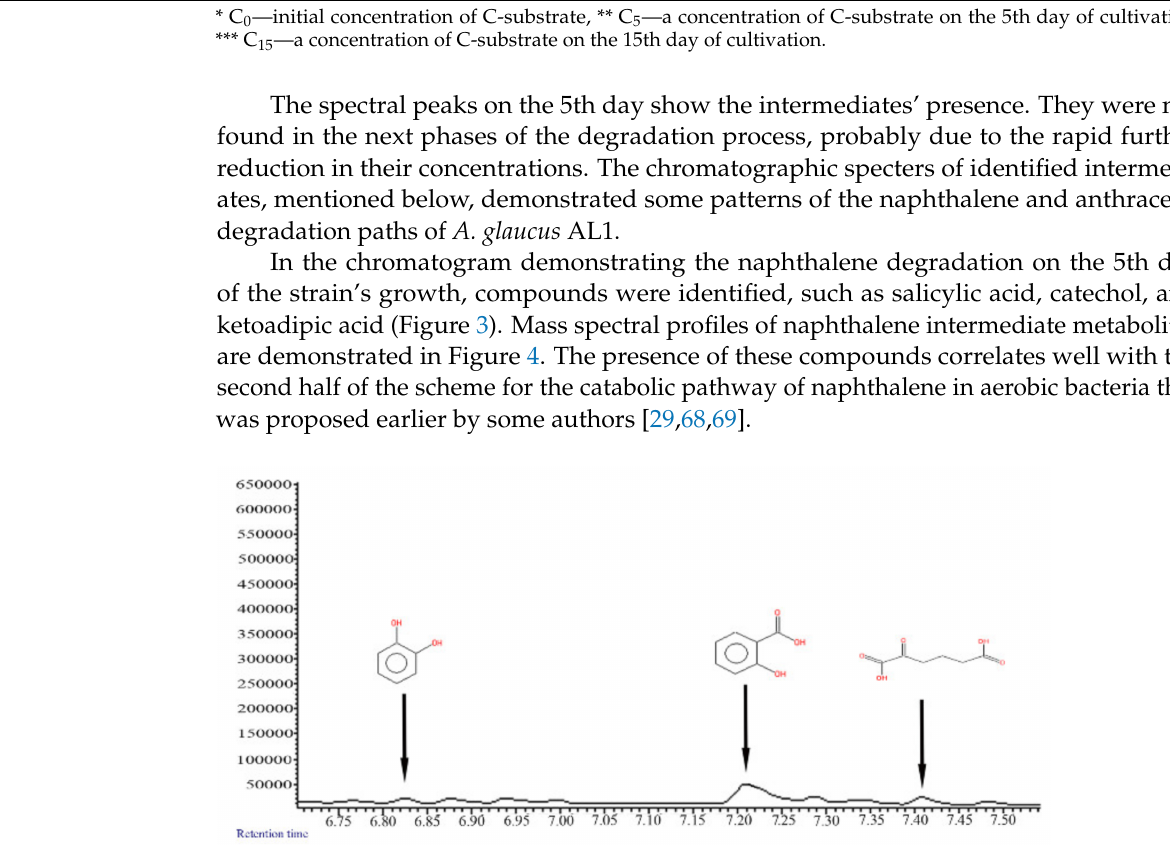
Figure 3. Gas chromatographic analysis of naphthalene metabolites—catechol, salicylic acid, and ketoadipic